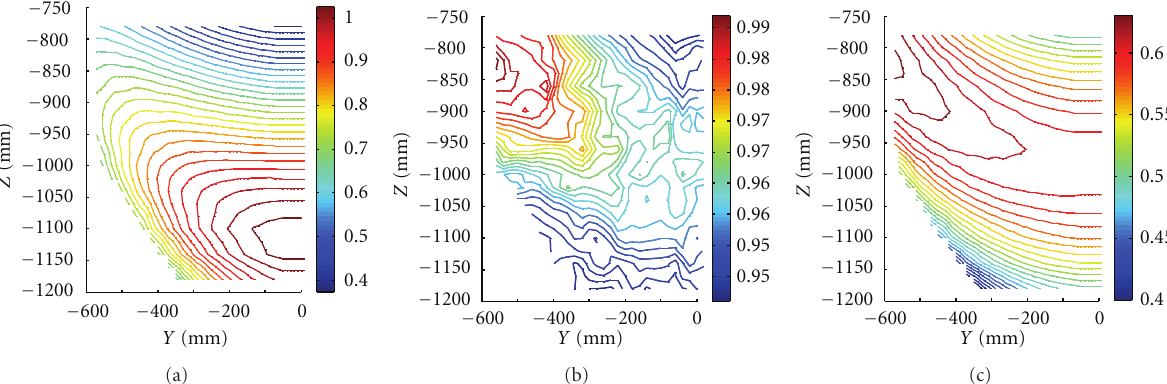
Figure 19: Manipulability index μ t (a), normalized velocity along the Z direction (b), and DSI μ Z computed in the vertical half-plane YZ with X = 0mm (c).